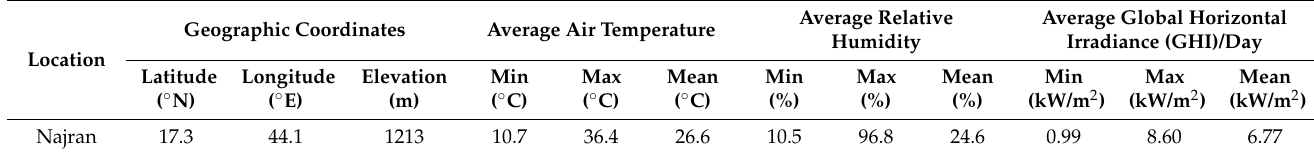
Table 1. Climate characteristics of selected location [26].